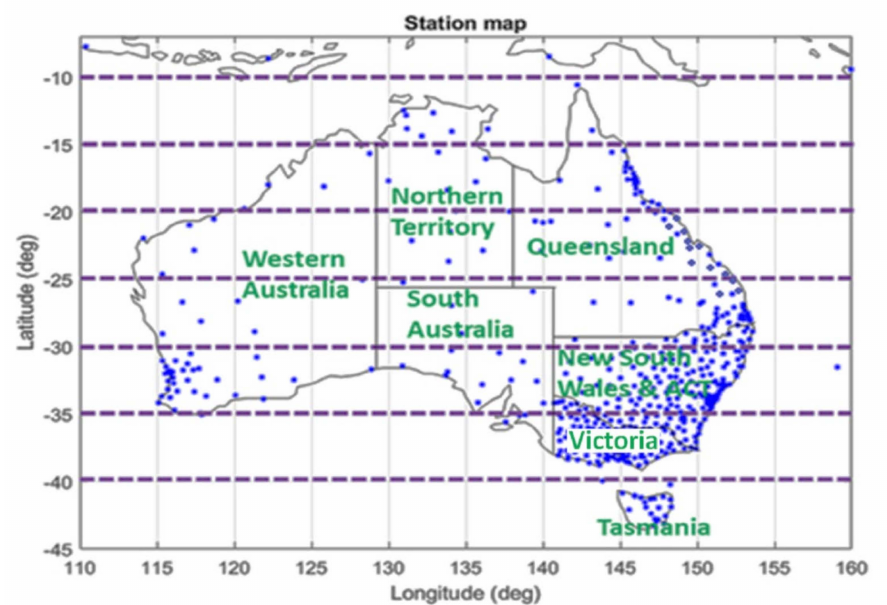
Figure 1. A map showing the geographical distribution of the Australian GNSS CORS networks (blue point). The test regions have a latitudinal width of 5 ◦ north south, whereas the longitudinal length varies between 8 to 12 ◦ east west.